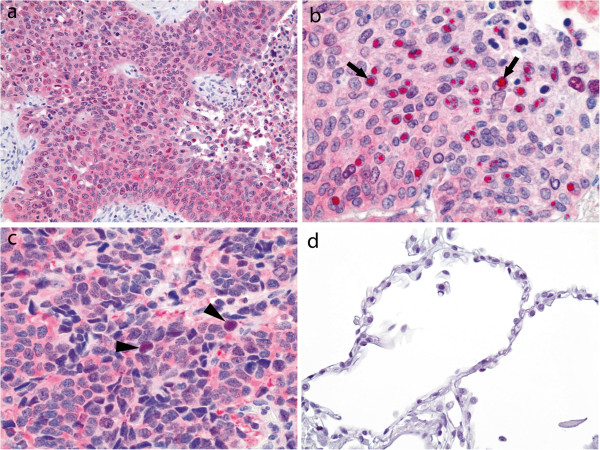
Patterns of PRMT5 expression in surgically resected lung tumors. Cytoplasmic PRMT5 is seen diffusely throughout a tumor (a-c) while nuclear expression varies (b-c); squamous cell carcinoma (a-b); small cell lung carcinoma (c); immunohistochemistry, original magnification ×200, ×600, and ×600, respectively. A distinct nuclear accumulation of PRMT5 forming varying in size intranuclear globules is seen in squamous cell carcinoma, arrows (b); in contrast, nuclear accumulation of PRMT5 in small cell lung carcinoma is finely granular, arrowheads (c). No PRMT5 expression is seen in alveolar parenchyma away from tumors (d), immunohistochemistry, original magnification ×400.